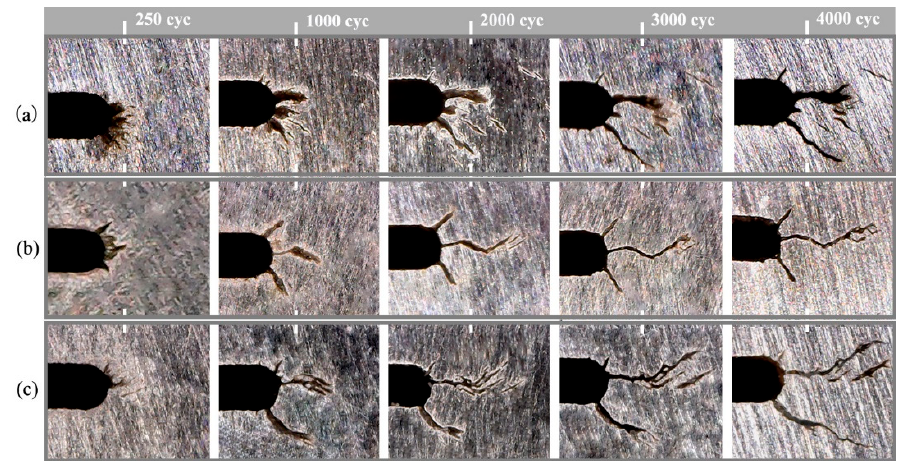
Figure 7. Crack images of the ( a ) As ‐ SLMed, ( b ) T ‐ SLMed, and ( c ) Forged H13 after different numbers of TF testing cycles.